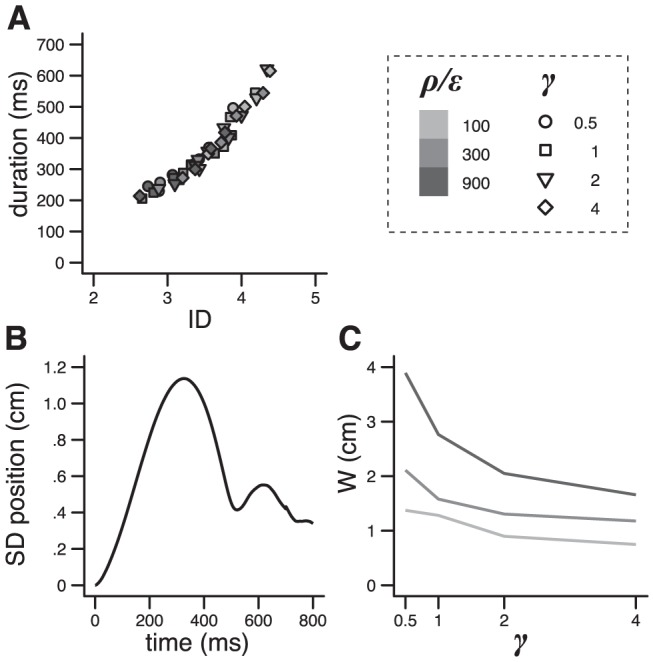
Fitts' law and variability.
A. Duration as a function of the index of difficulty (ID) for 3 distances (10, 20 and 30 cm) and different values of vigor and discount (see legend). B. Typical spatiotemporal variability (s.d. of position). C. Endpoint variability for different values of the discount factor. Color is for the level of vigor (legend in A). Results obtained with Object II. Parameters: distance = 30 cm, r = 1, ρ/ε = 100, γ = 2, σSINs = .001, σSDNm = 1.